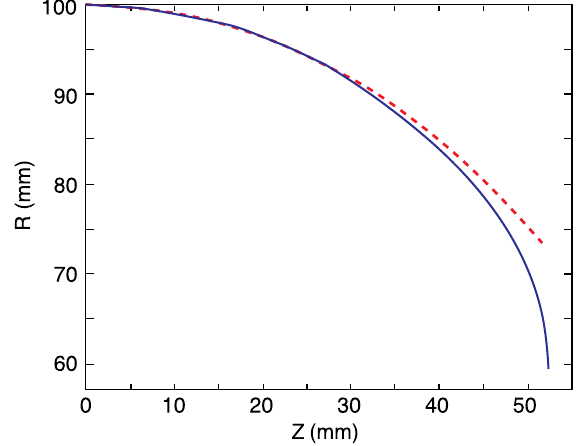
FIG. 6. The upper elliptic arc (solid blue line) and parametric curve (dashed red line) for the linear approximation for E s .